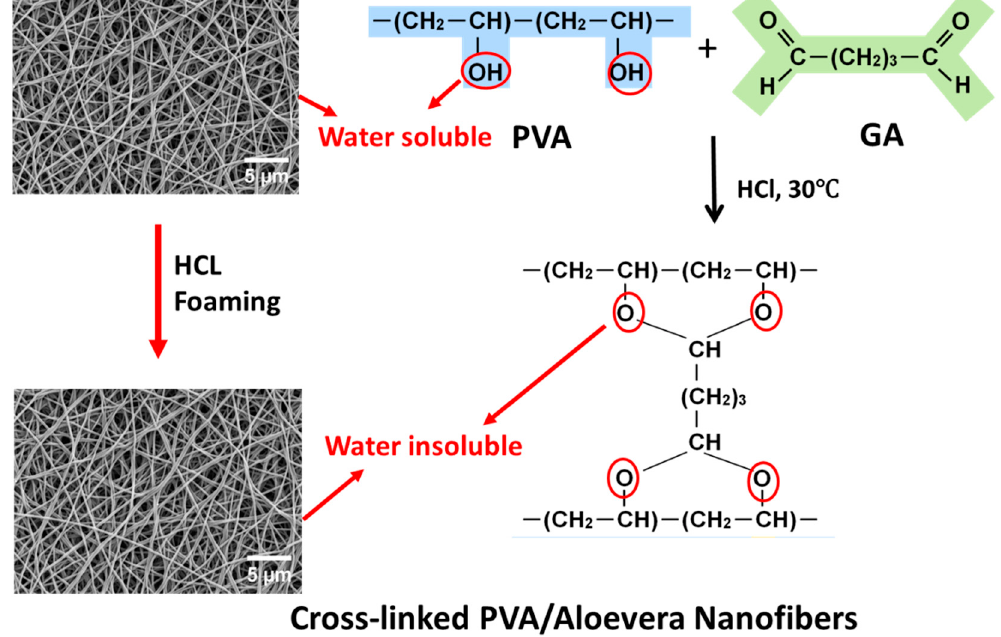
Figure 2. Crosslinking of PVA/Aloe vera nanofibers.